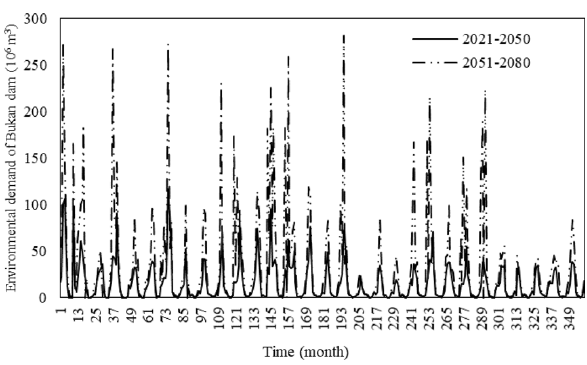
Figure 7. Environmental water demands of the Bukan reservoir in the two future